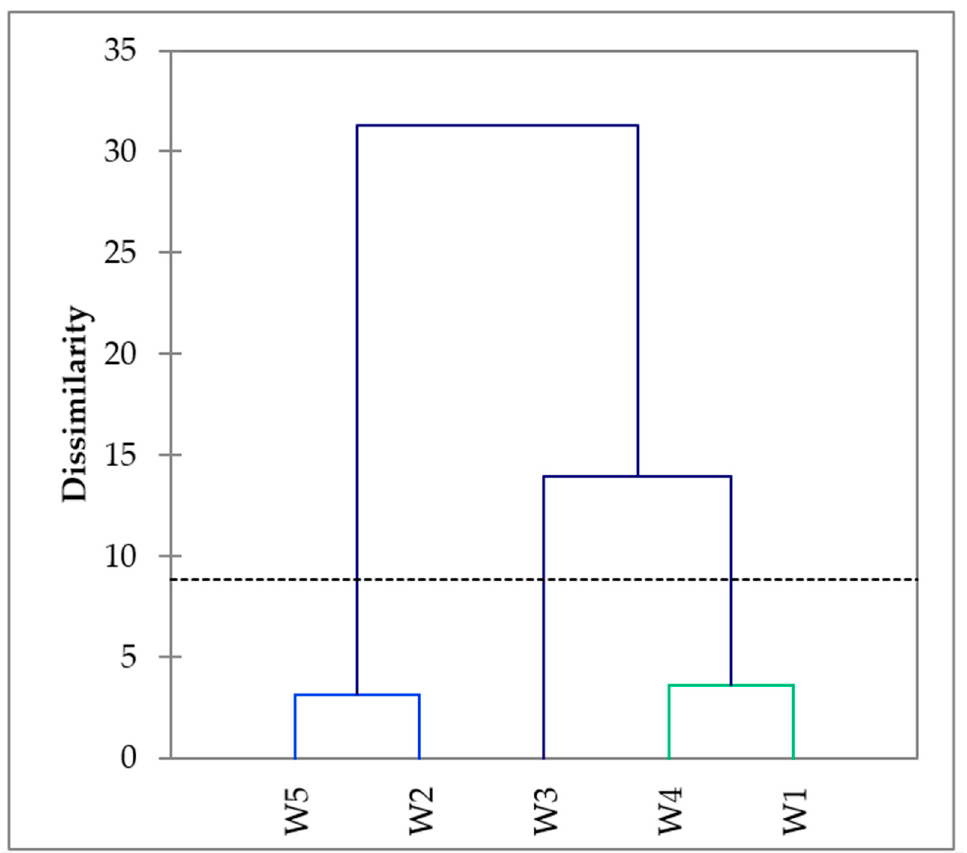
Figure 3. Dendrogram obtained from the Check-All-That-Apply (CATA) evaluation by the consumer panel of the white wines. panel of the white